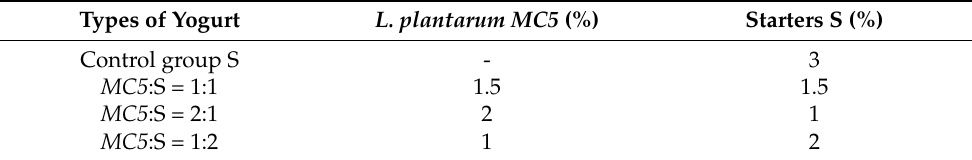
Table 2. Inoculated amount of MC5 and starters in four groups of yogurt samples. Types of Yogurt